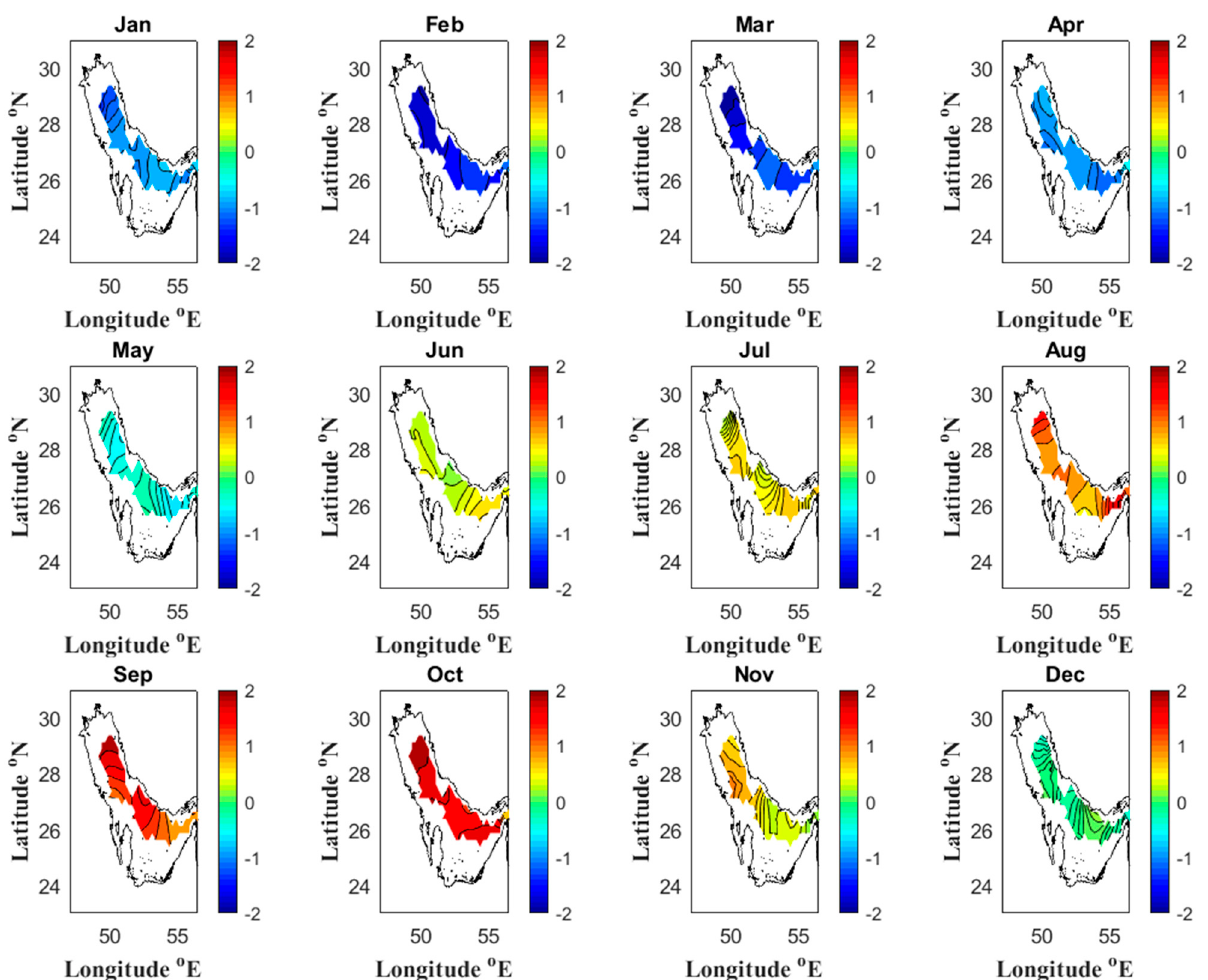
Figure 7. Monthly OHC (×10 7 Jm − 2 ) anomalies to 35m.